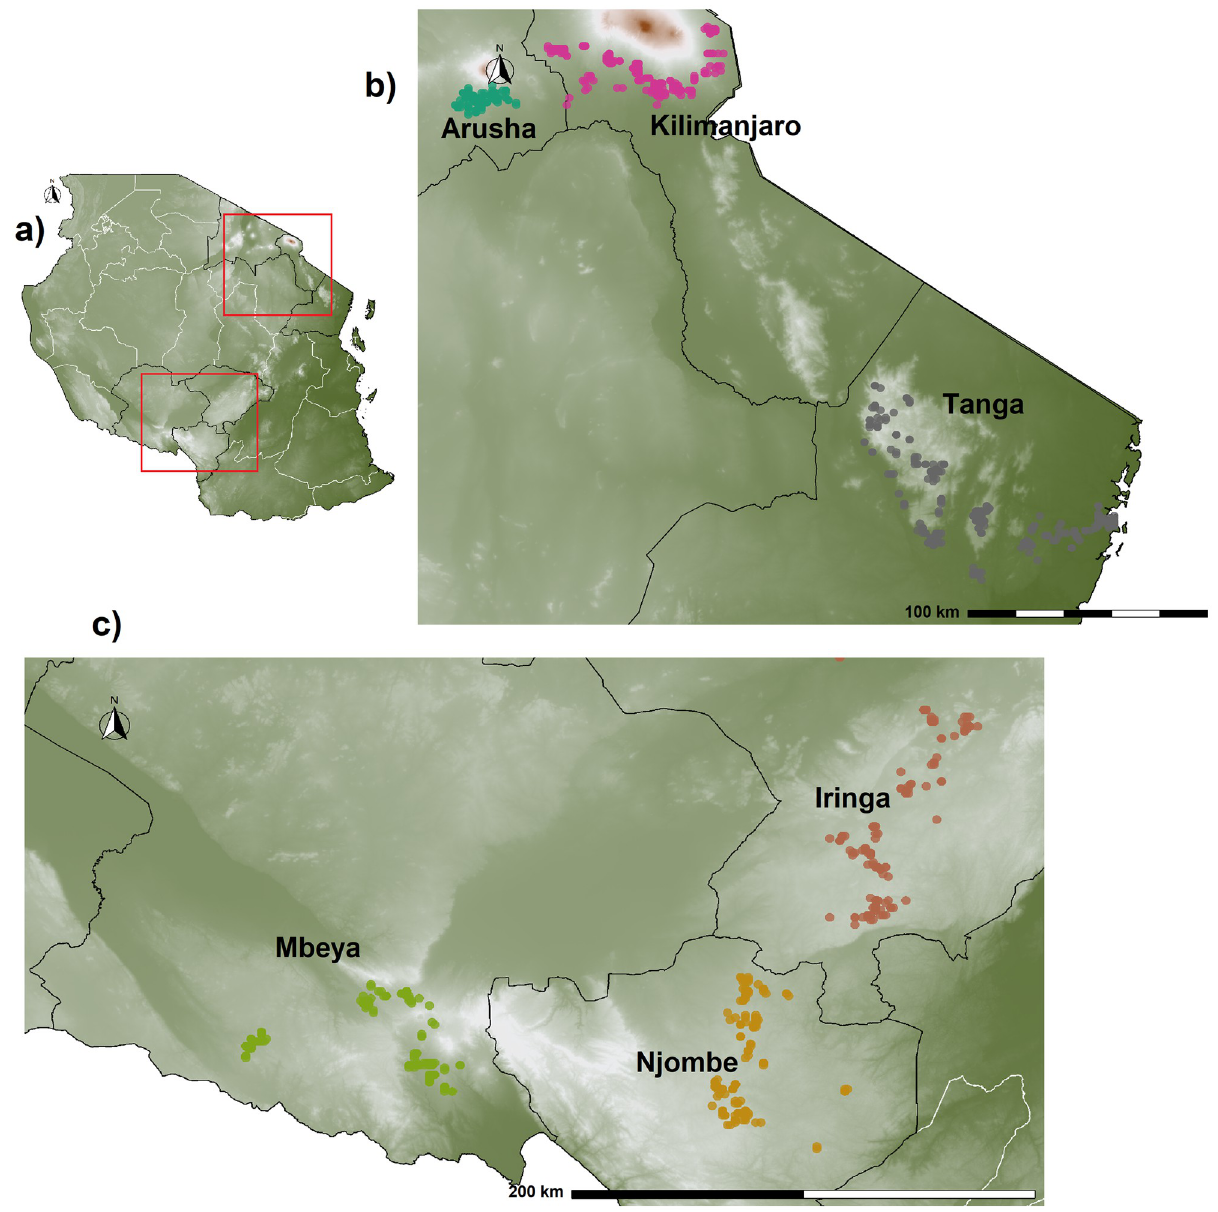
Fig 1. Geographic location of farms, regions, and dairy zones in Tanzania. a) , geographic location across six regions from two economically important dairy zones over an elevation map of Tanzania. Red squares indicate the important dairy zones. b) , a close-up of the northern zone integrated by the regions of Arusha, Kilimanjaro and Tanga in which a total of 12 districts were sampled. c) , a close-up of the southern highland zone of Tanzania integrating the Iringa, Njombe, and Mbeya regions in which 11 districts were sampled. In all panels, farm location (dots) is colour-coded to indicate their administrative region. Map source: https://www.usgs.gov/centers/eros/science/usgs-eros-archive-digital-elevation-global-multi-resolution-terrain- elevation.